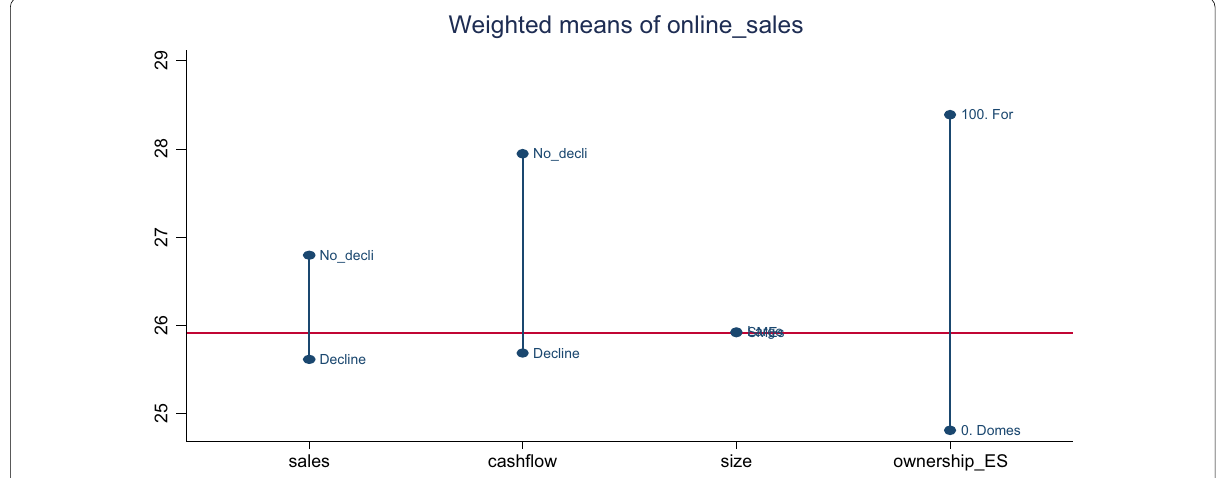
Fig. 1 Percentage of Enterprises’ sales online based on sales, cash-flow and moderators decline in SSA. Source : authors’ construct based on Covid-19 ES follow-up survey